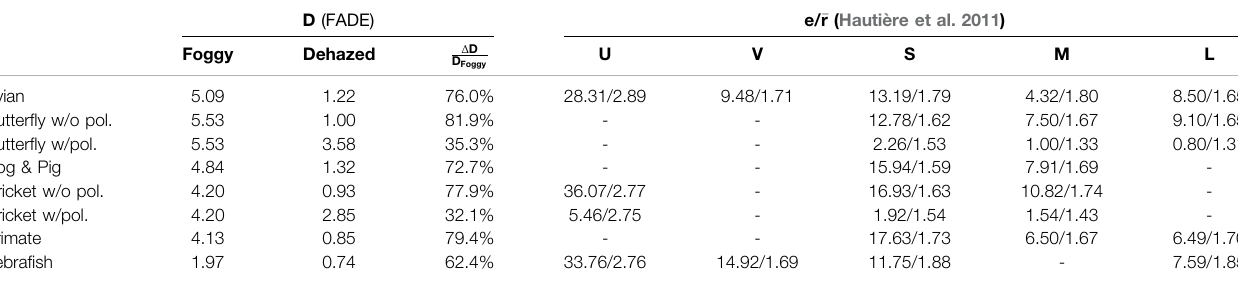
TABLE3| Evaluationresultsofdehazingforscene2.Theevaluationmetric D (FADE(ChoiandYou,2015))isappliedonsRGBimages,whereasthemetrics e and (cid:1) r (Hautière et al., 2011) are applied per spectral